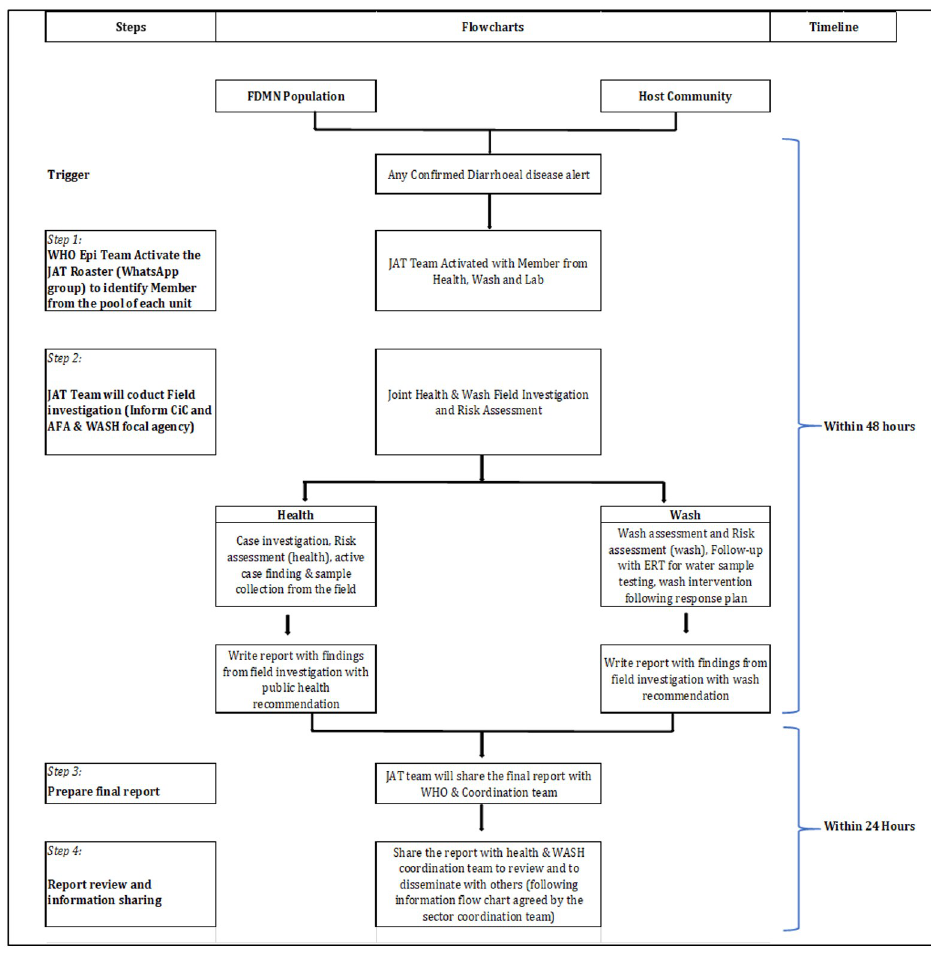
Fig 3. Joint assessment team operational